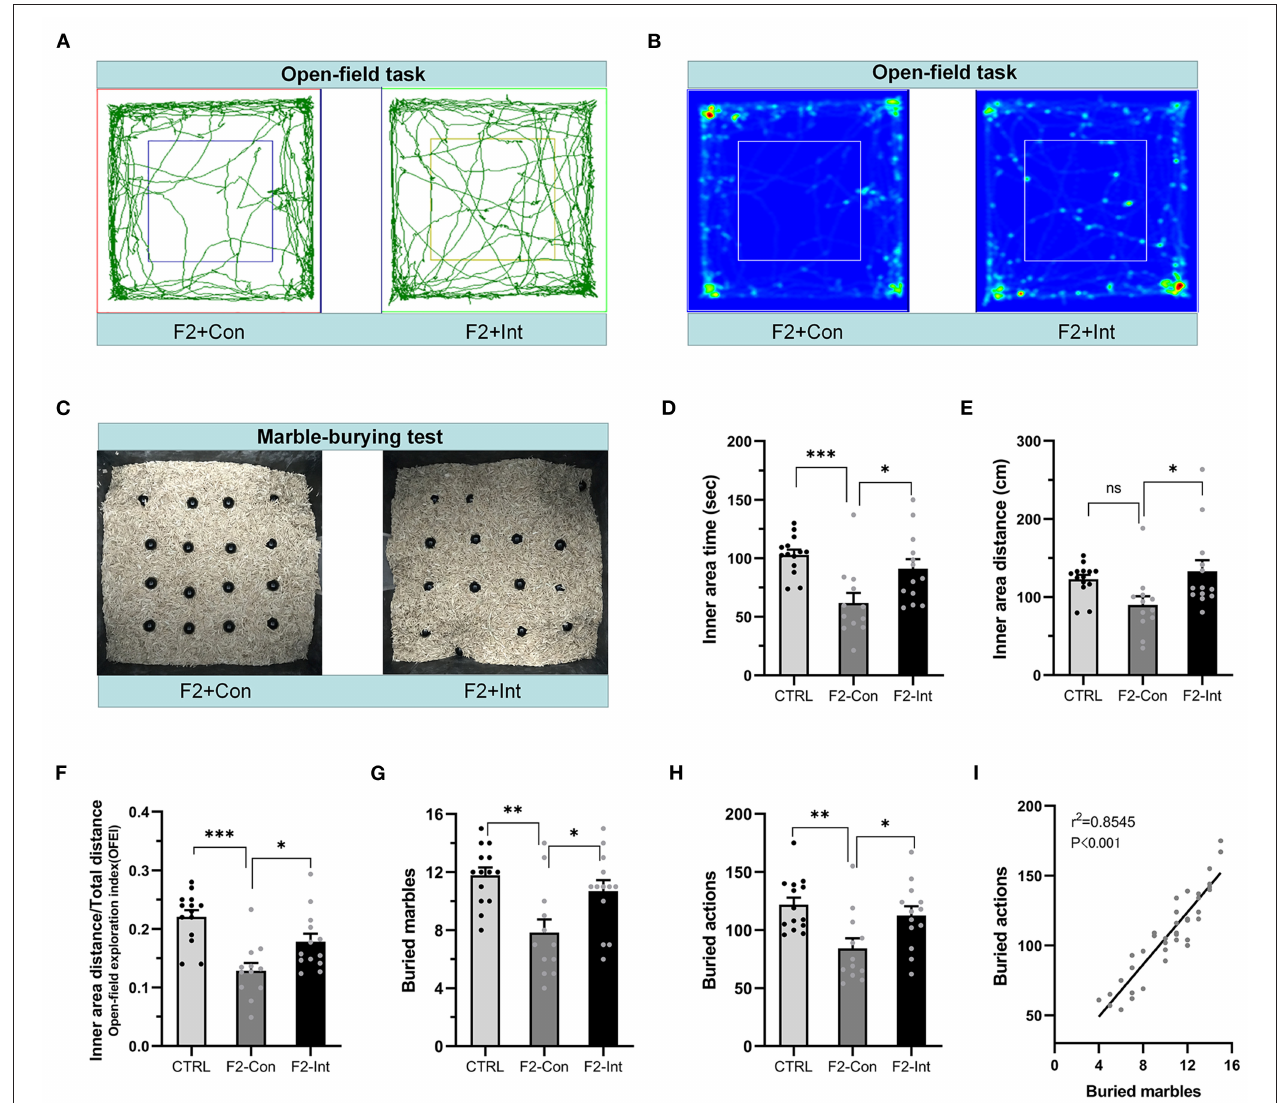
FIGURE 5 | Prenatal baclofen administration corrected locomotor, exploratory activity, and marble-burying deficits in F2 mice. (A) Representative traces of mice in the open-field task. (B) Representative heatmaps of traces of mice corresponding to (A) . (C) Representative marble-burying maps after the marble-burying test. (D) Time traveled in the inner zone by mice. (E) Distance traveled in the inner zone by mice. (F) The open-field exploration index (OFEI = distance traveled in the inner zone/the total distance traveled) of mice. (G) The numbers of buried marbles of mice. (H) The number of burying actions of mice. In (D–H) and (G–I) , one-way ANOVA followed by the Bonferroni post-hoc test was used to compare the differences among groups: * p < 0.05, ** p < 0.01 *** p < 0.001. All data for all figures are plotted as the mean ± SEM. n (CTRL: F2-Con: F2-Int) = 14:12:13. (I) Pearson correlation and linear regression analysis between the number of buried marbles and the number of burying actions. All mice were included ( n = 39) in the analysis, and there was a linear correlation between the number of buried marbles and the number of burying actions. HC, we did not observe significant differences in the spine density on basal dendrites of CA1 pyramidal neurons among the CTRL, F2-Con, F2-Int groups of mice.